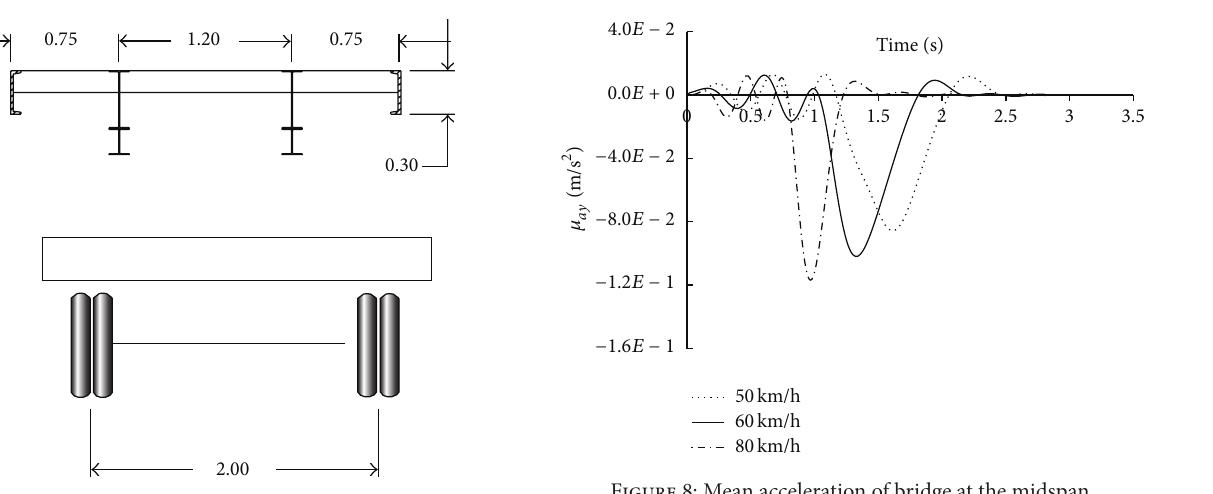
Figure 5: Vehicle cross-section (all dimensions are in meter).